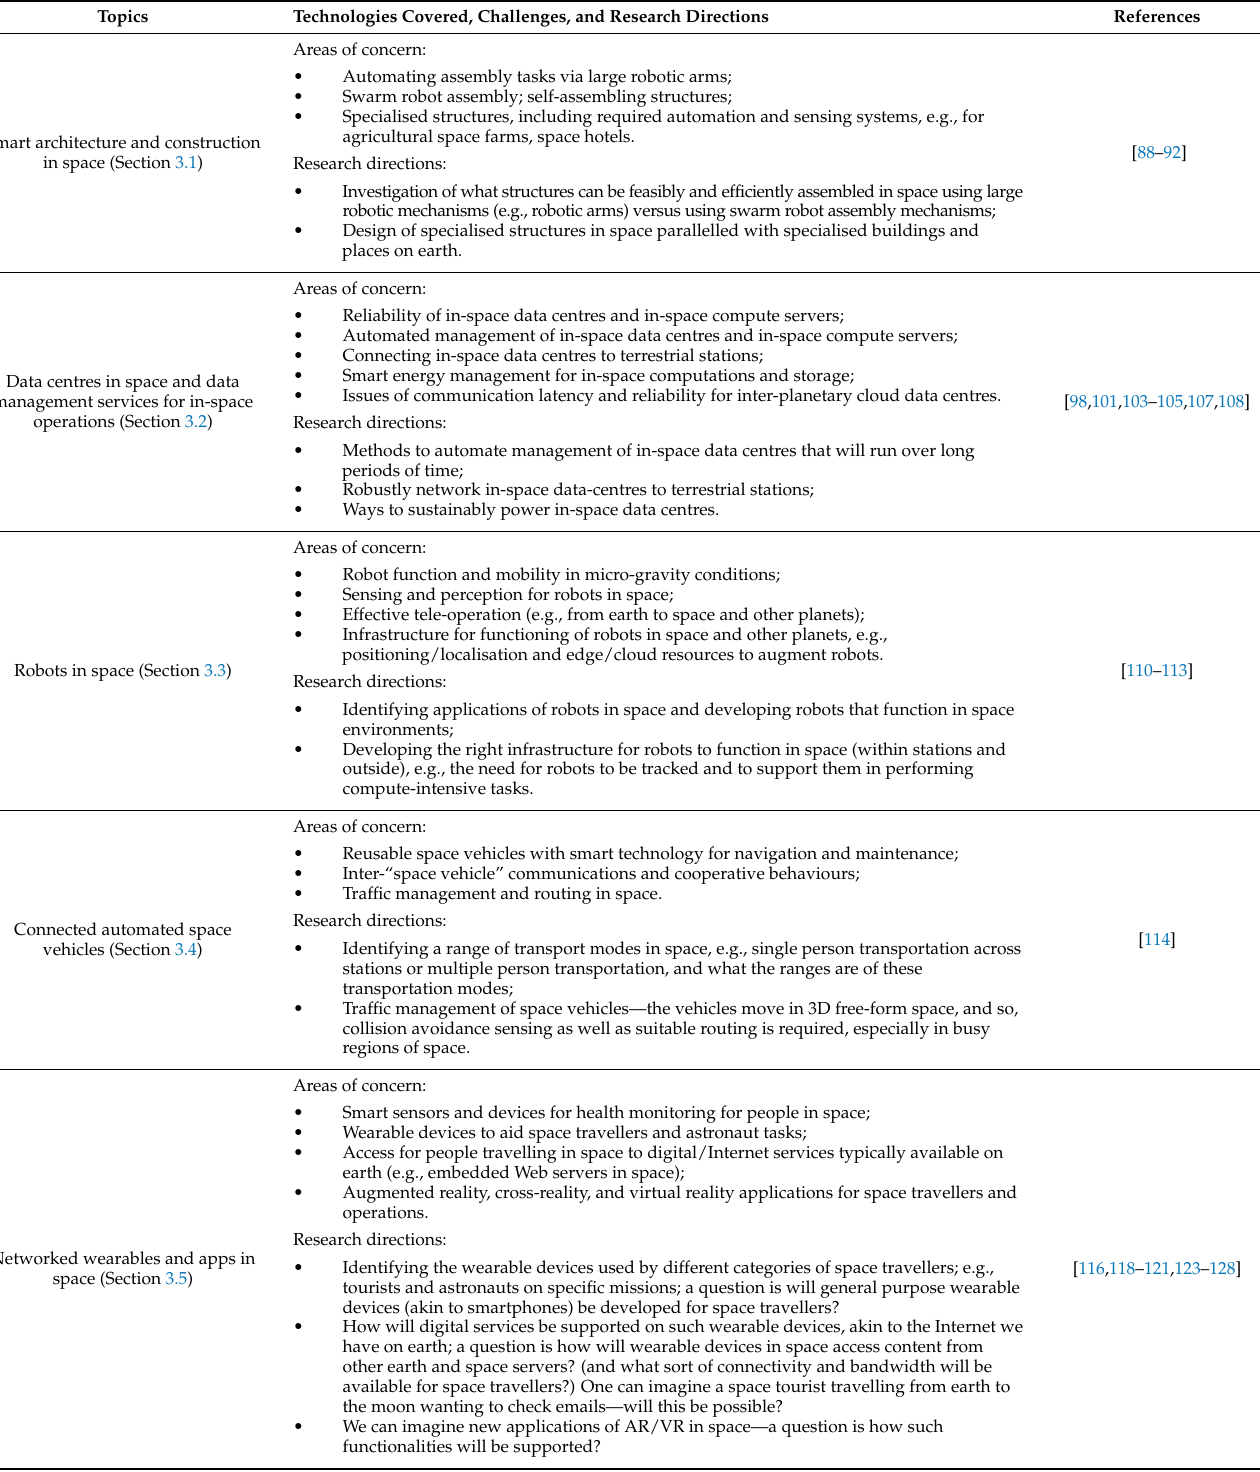
Table 2. Summary of the topics, their areas of concerns and research directions (with representative references) as described in Section